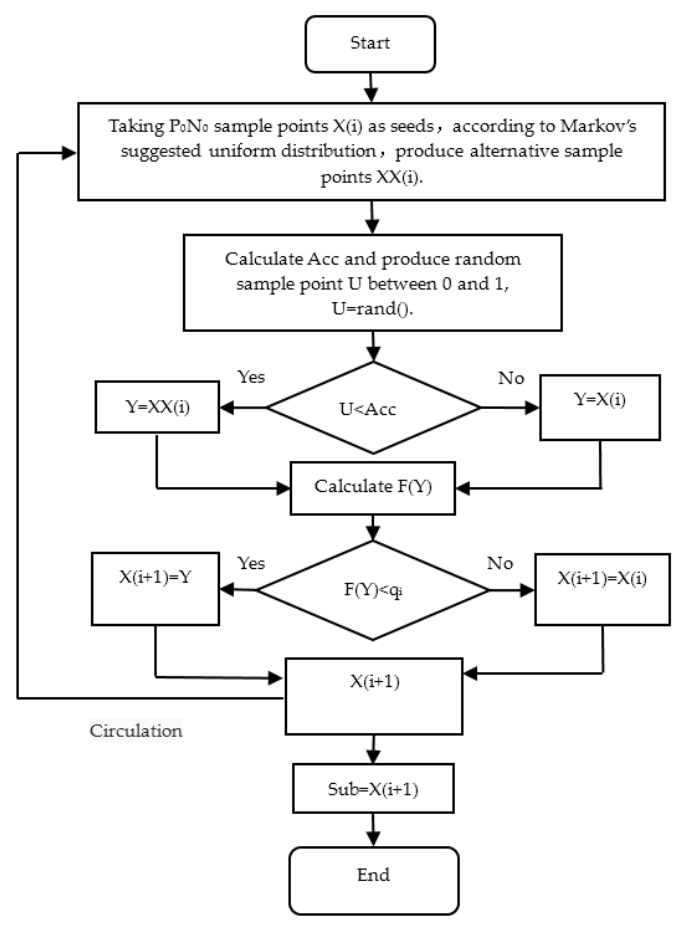
Figure 8. Subroutine flow chart of Markov chain in subset simulation.